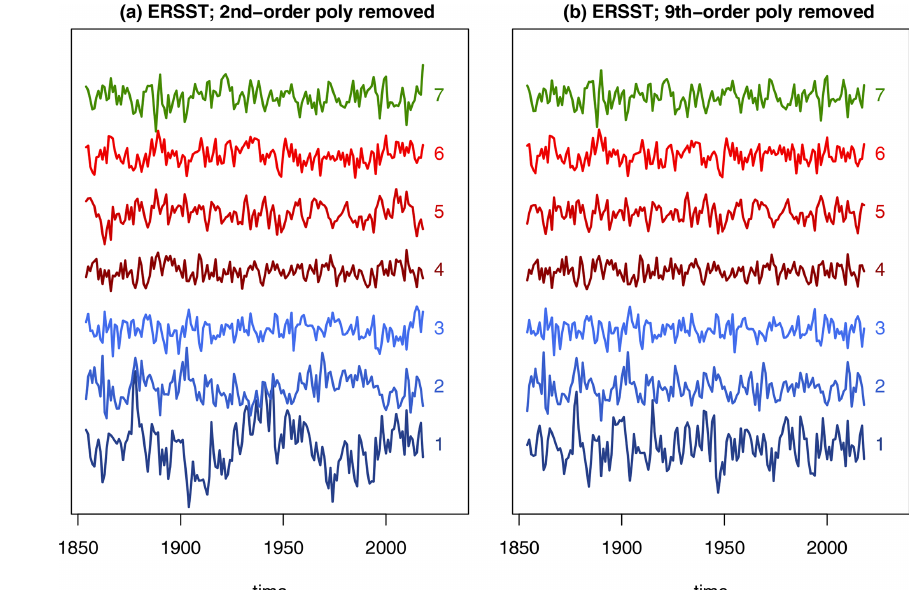
Figure 3. Projection of SST anomalies from ERSSTv5 onto the first seven Laplacian eigenvectors of the North Atlantic domain. Panels (a) and (b) show, respectively, anomalies derived by removing second- and ninth-order polynomials in time. The integers on the right end of each time series indicate the Laplacian